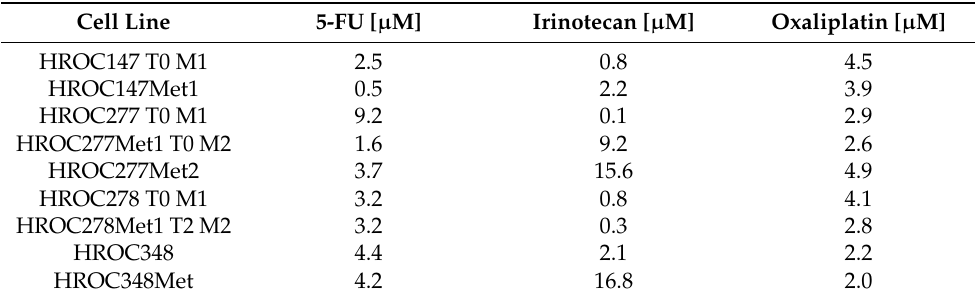
Table 3. IC 50 values of colorectal cancer (CRC) cell lines. Calculations were based on chemosensitivity in vitro assays ( n = 5–8 biological replicates consisting of technical